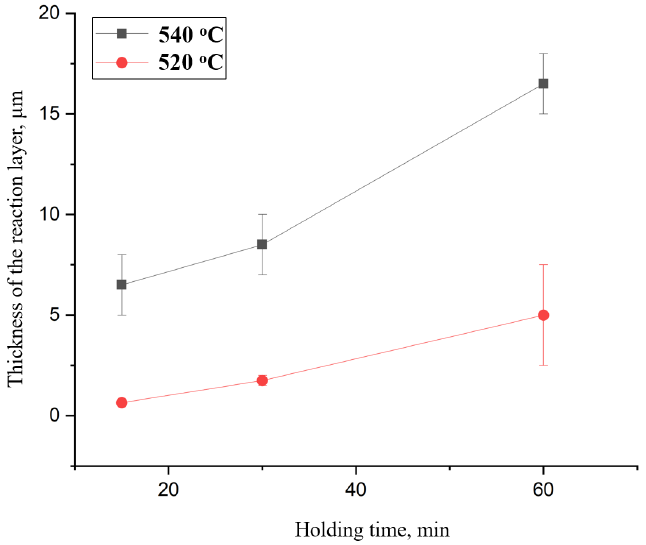
Figure 15. Dependence of the reaction layer width on the holding time during brazing at different